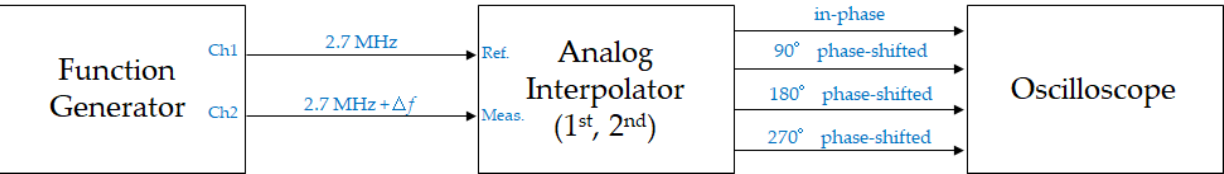
Figure 8. Block diagram of the analog interpolator testing.